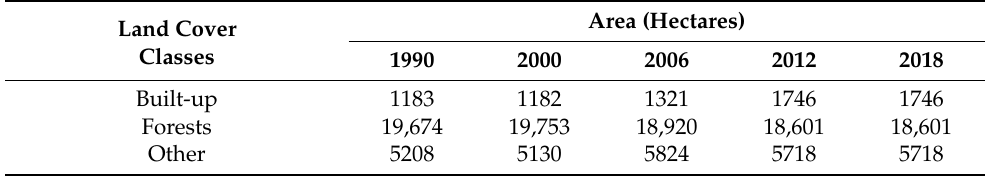
Table 1. Reclassified land cover classes areas dynamics between 1990 and 2018.